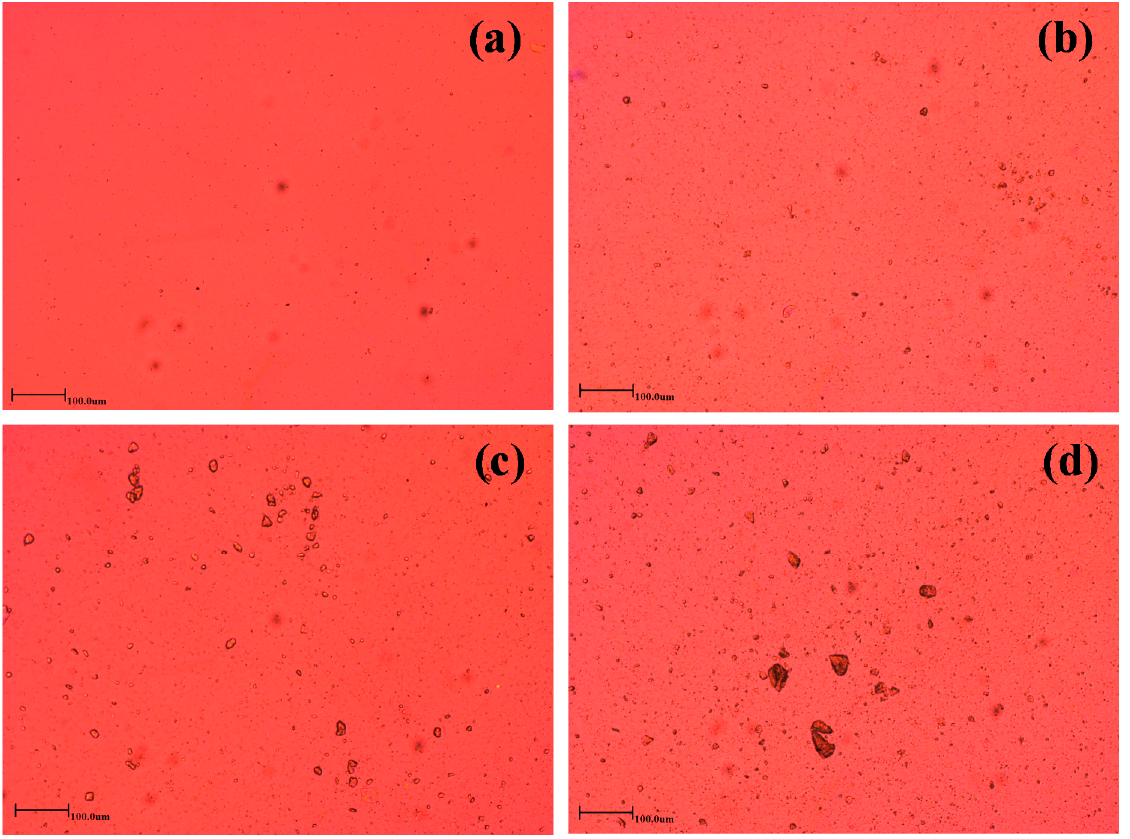
Figure 2. Optical microscopy images of ( a ) PCL 1, ( b ) PCL 3, ( c ) PCL 5, and ( d ) PCL 7 at melt temperature of 100 °C.